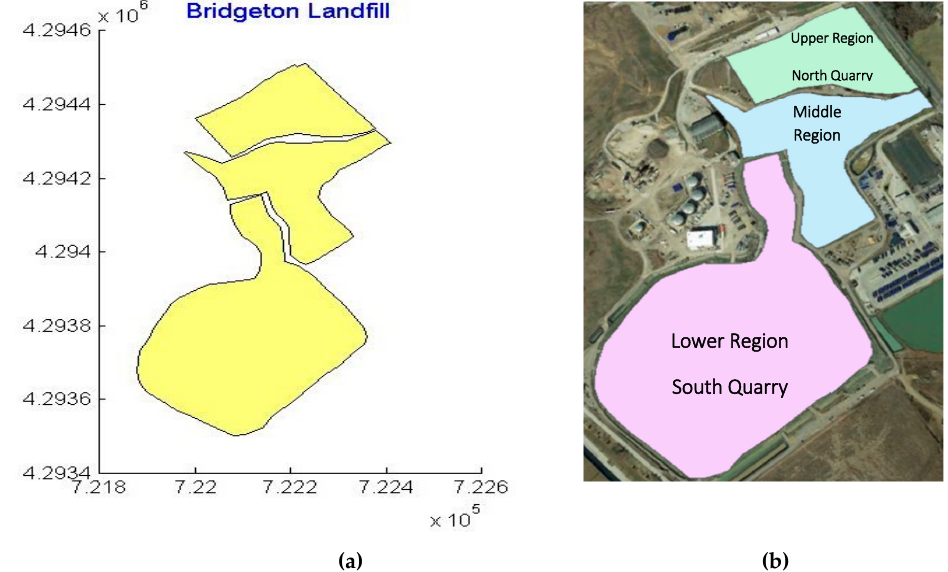
Figure 2. ( a ) Bridgton Landfill, divided by regions, and the surrounding area. ( b ) Latitude and longitude of the landfill and overlay of regions on Google